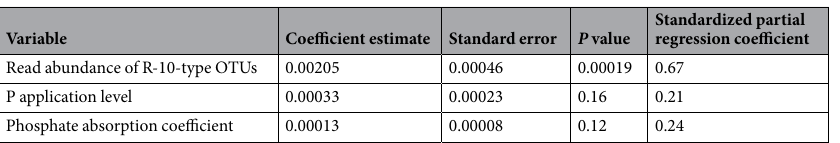
Table 2. Effect size of biotic and abiotic factors on yield response to R-10 inoculation estimated by multiple linear regression analysis.